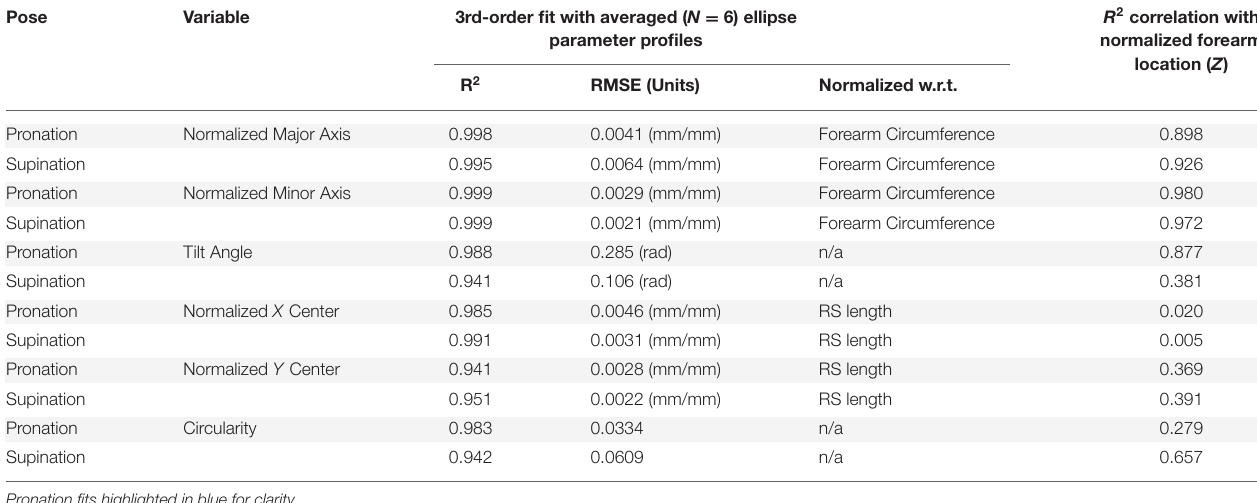
TABLE 2 | RMSE of CS2 3rd-order ellipse-fit model parameter with six-subject averages and R 2 correlation with normalized forearm location.